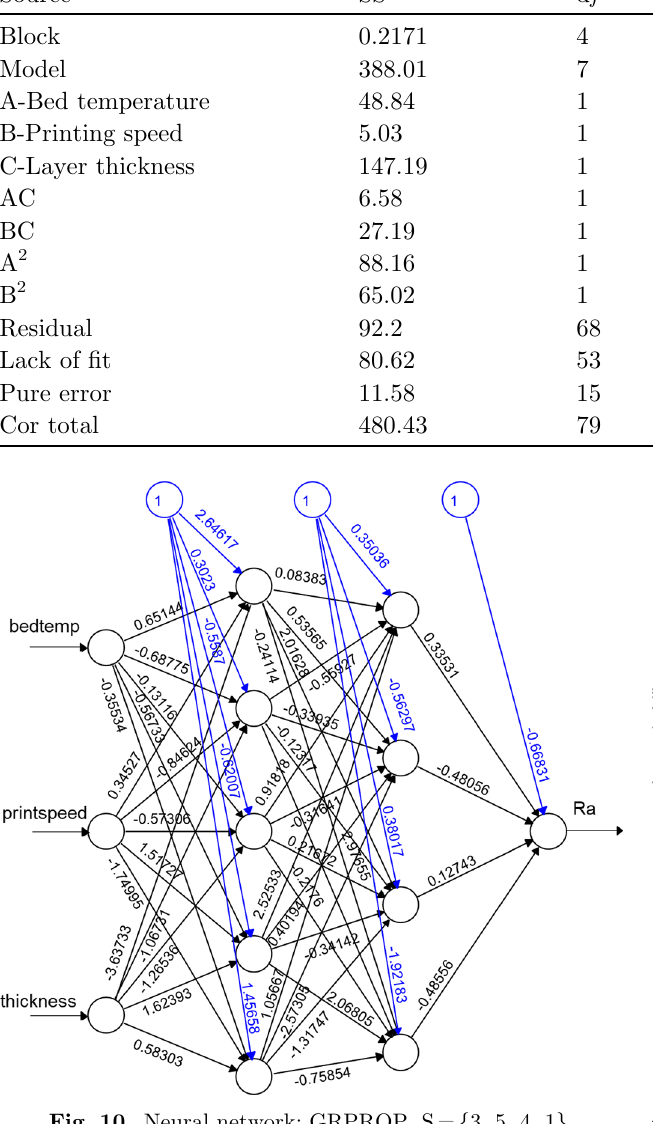
Fig. 11. Normal probability plot of residuals (top surface